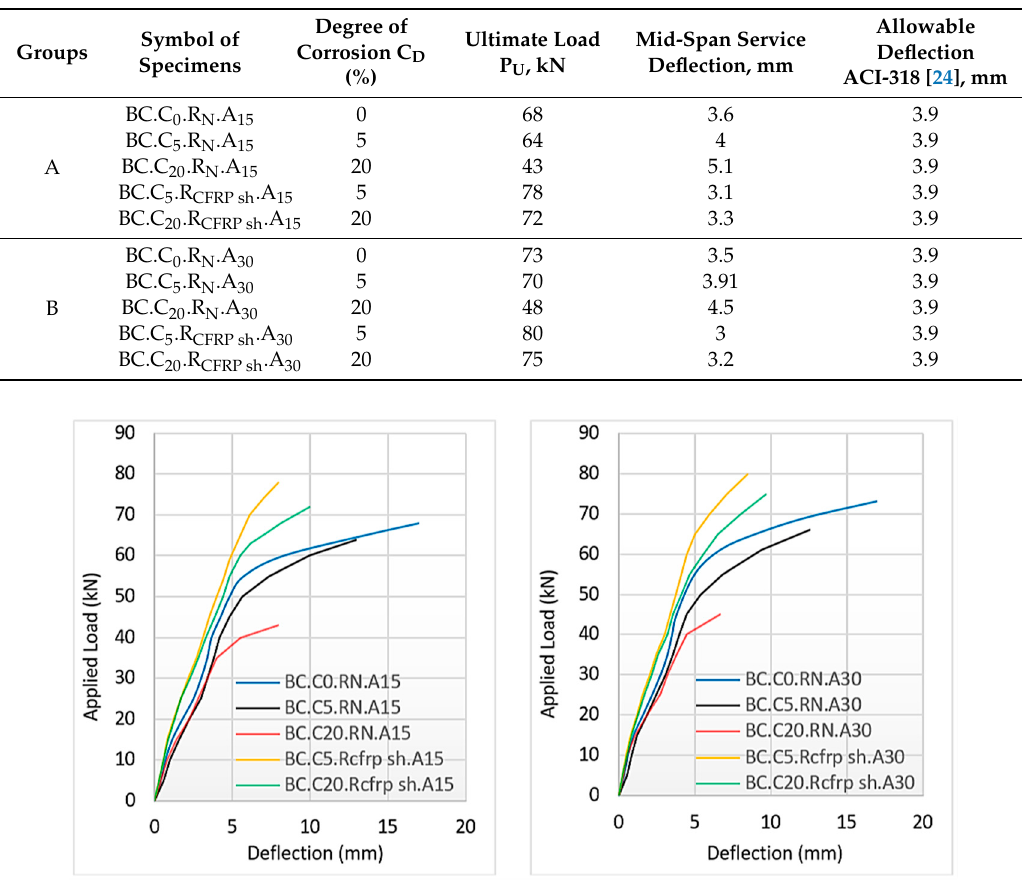
Table 3. Ultimate load capacity, service deflection, and allowable deflection according to American concrete institute: ACI for tested specimens.